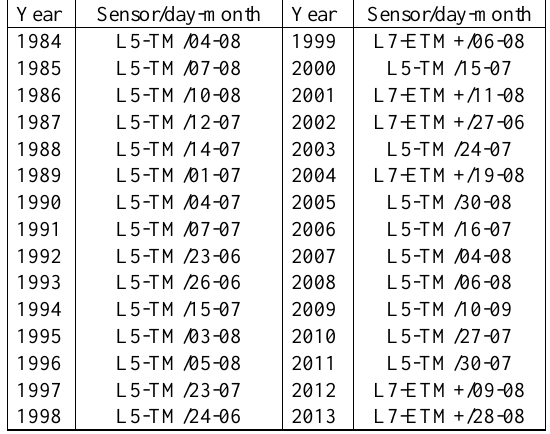
Table 1. Selected Landsat TM/ETM+ images, path/row-231/66.